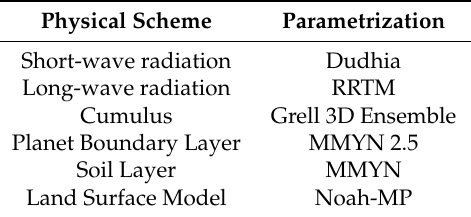
Table 2. Final WRF simulation